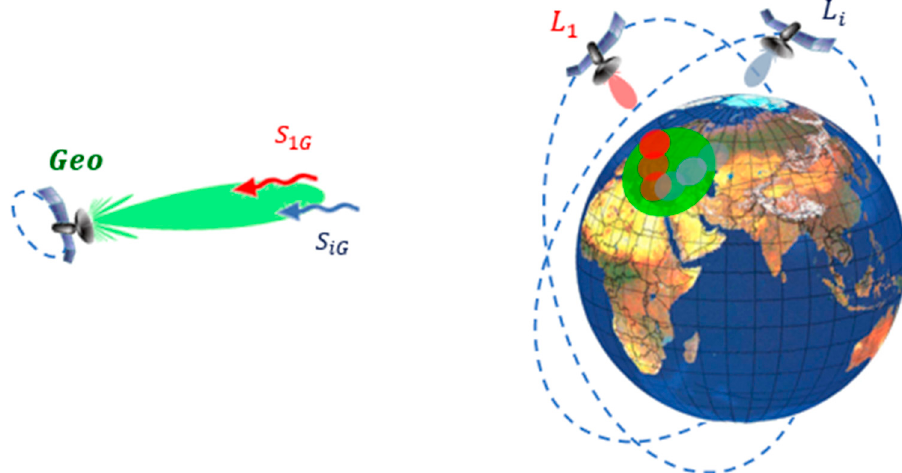
Figure 1. Geometry of a geostationary synthetic aperture radar (SAR), “Geo”, affected by interferences due to the signal backscattered from a set of low Earth orbiting (LEO) SARs, L 1 and L i .